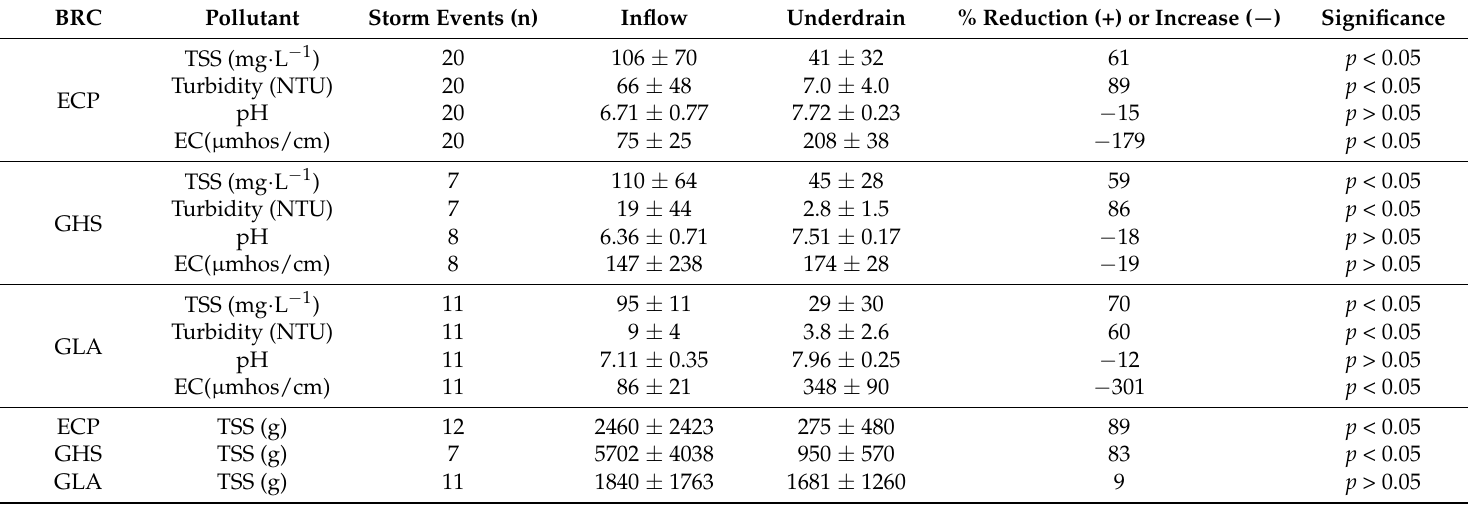
Table 5. Mean influent and effluent water quality parameters monitored at three bioretention cells (BRC) at Grove, OK from 2014 to